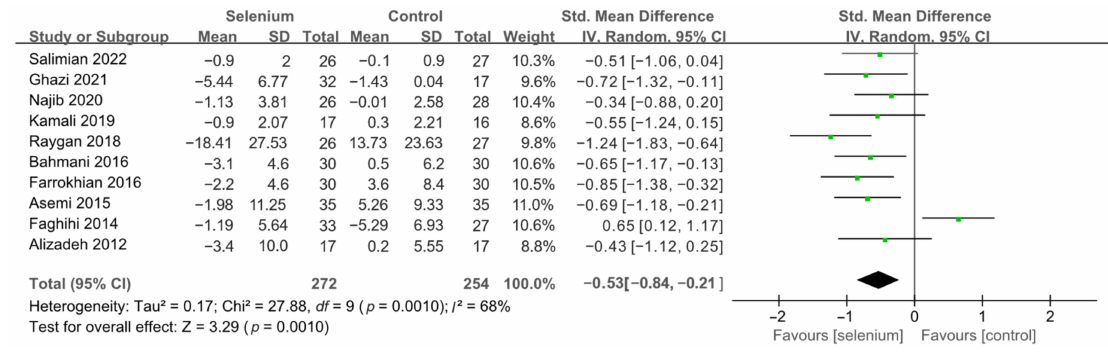
Figure 4. Forest plot of insulin levels [30,41–49].